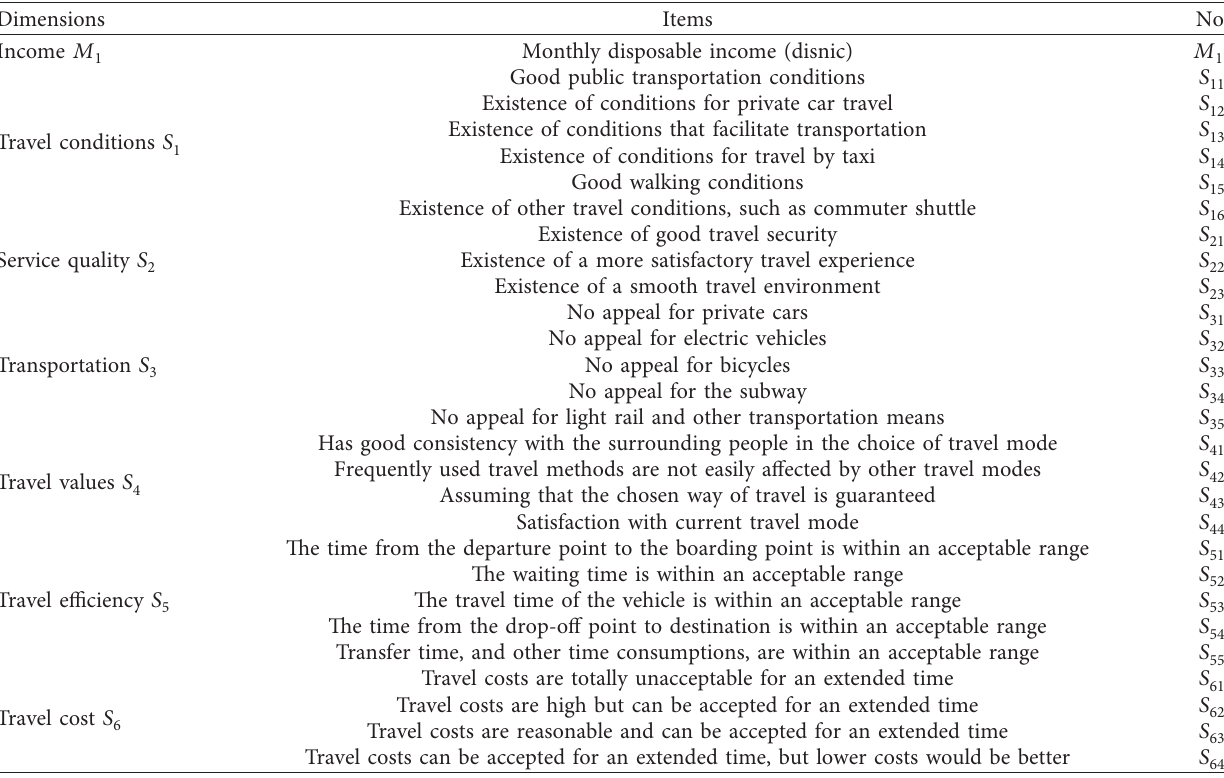
Table 2: Content of travel deprivation items.